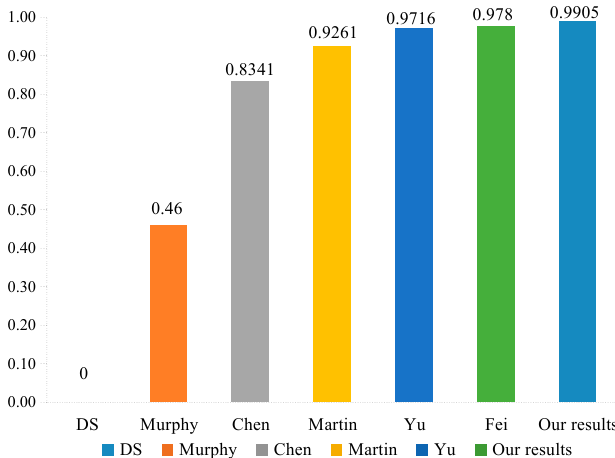
Figure 6. The comparison of the belief value allocation for target θ 1 in different methods.